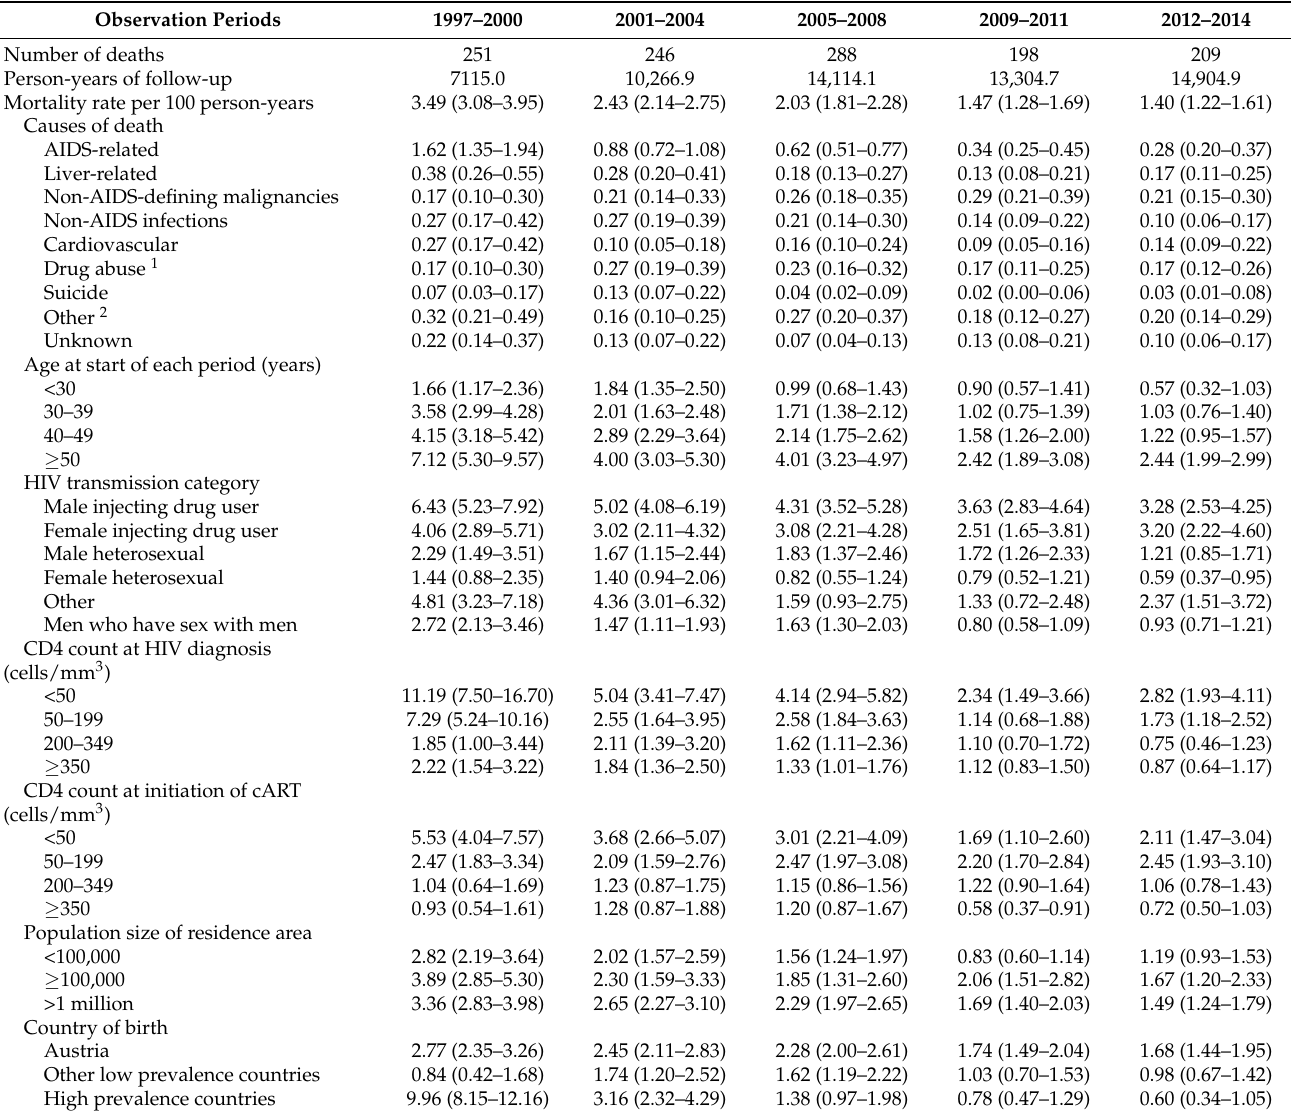
Table 2. Mortality rates in different calendar time periods.